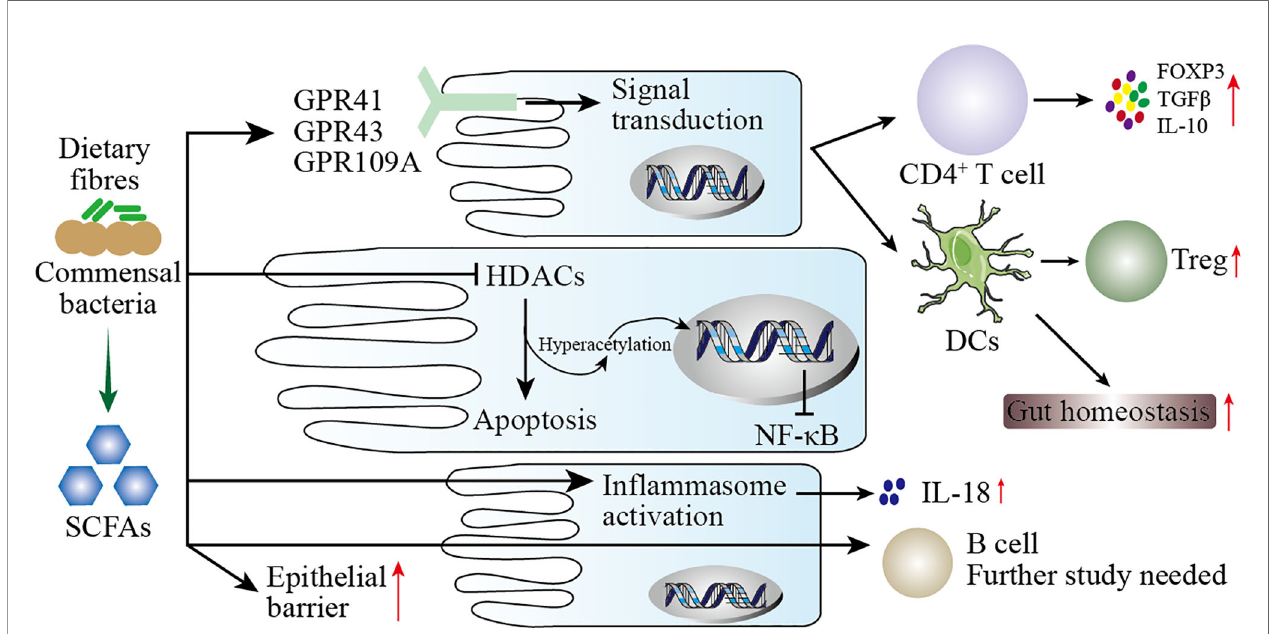
FIGURE 4 | Mechanisms of SCFAs regulating mucosal immunity. SCFAs are produced by the digestion of dietary fi ber by the intestinal microbiota. On the one hand, SCFAs increase the barrier function of the intestinal mucosa to protect the body from harmful microbes. On the other hand, SCFAs participate in the mucosal immunity of the intestine, speci fi cally: (1) SCFAs act on G protein-coupled receptors (GPR) on intestinal epithelial cells (IECs) to activate downstream cell signal transduction to regulate the immune response of T cells and dendritic cells (DCs). (2) After SCFAs enter IECs, they act as histone deacetylases (HDACs) inhibitors to affect the transcription of in fl ammatory genes. (3) SCFAs activate in fl ammasomes in IECs to promote the secretion of IL-18. (4) SCFAs directly pass through IECs to regulate the immune response of B